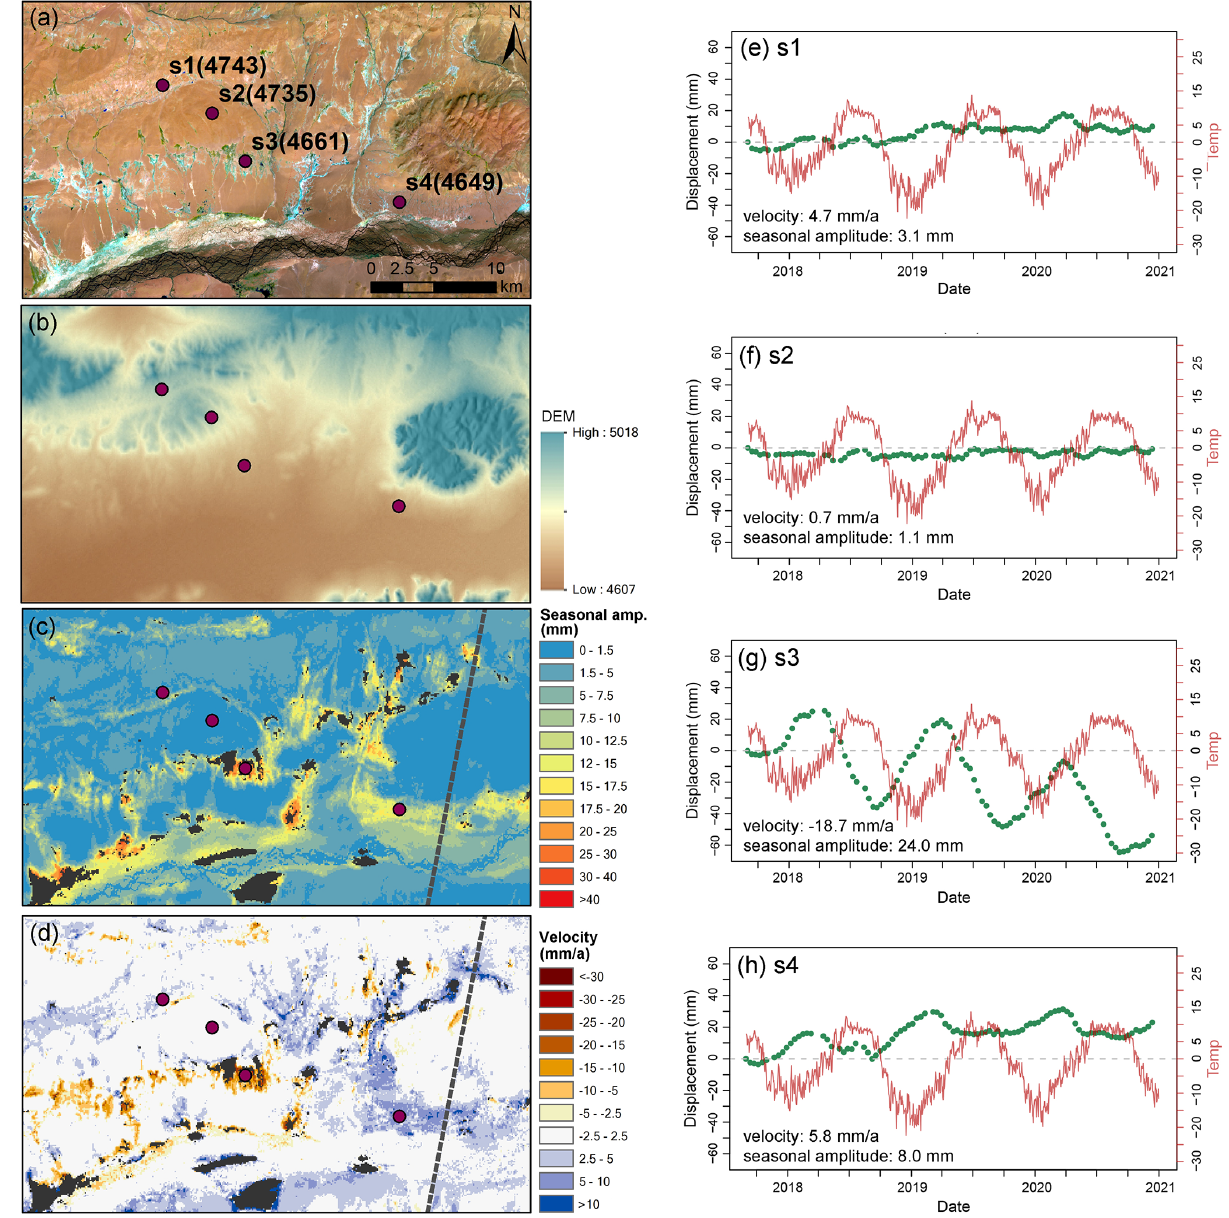
Figure 11. Deformation characteristics. This sector is marked with the red rectangle in Figs. 1 and 7–8. (a) Landsat 8 image (red: SWIR1, green: NIR, blue: red). (b) The DEM overlapped on the hillshade, which is calculated using the DEM with the Sentinel-1 incidence angle and azimuth angle. Panels (c) and (d) are seasonal deformation amplitude and long-term deformation velocity, respectively. The dashed grey line delineates the track boundary of orbit 150. Panels (e) – (h) are deformation time series of marked sites. The sites’ elevations (ma.s.l.) are labeled in parentheses in panel (a) . Air temperature in a red color is from ERA5-Land air temperature reanalysis data. Deformations are in the LOS